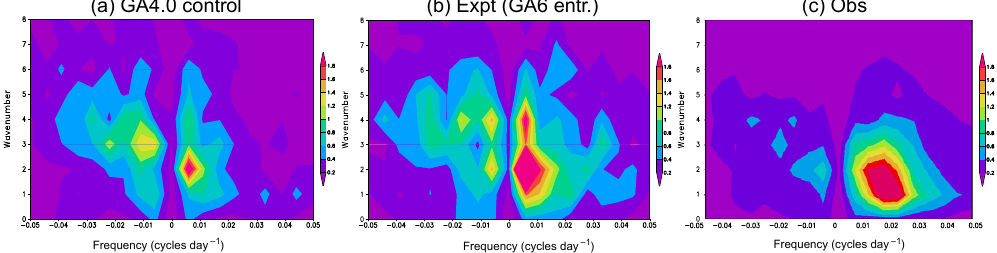
Figure 5. Wavenumber–frequency power spectra of boreal winter outgoing longwave radiation from (a) GA4.0, (b) GA4.0 but with the GA6 entrainment profile and (c) from NOAA satellite